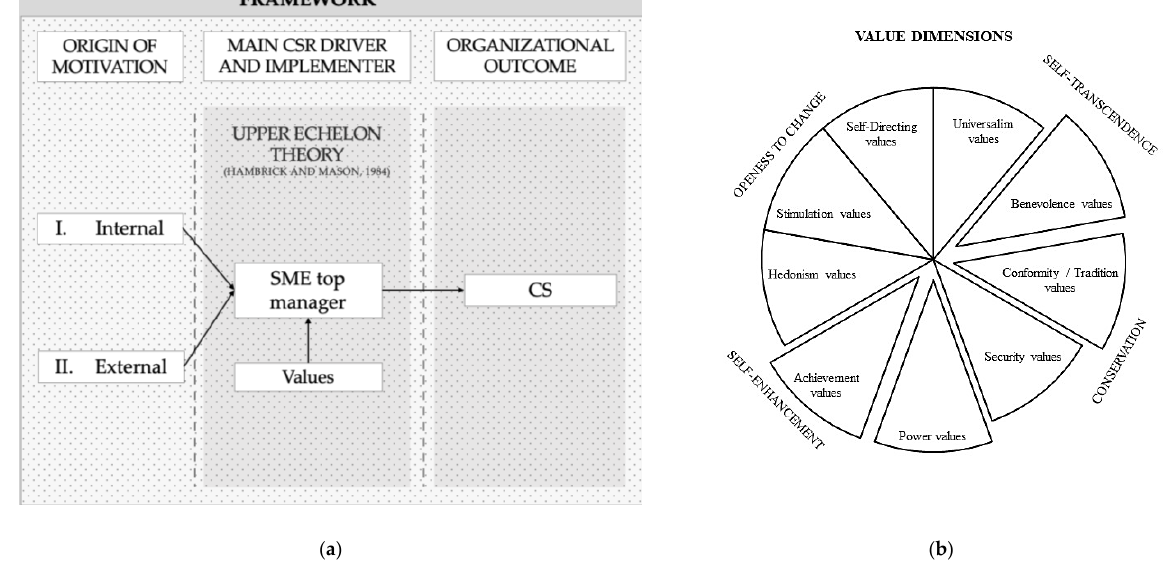
Figure 1. Research framework. ( a ) Own depiction according to Dacin et al. (2010) and Colovic et al. (2019). ( b ) Own depiction according to Schwartz (2012) and Schwartz and Bilsky (1987).